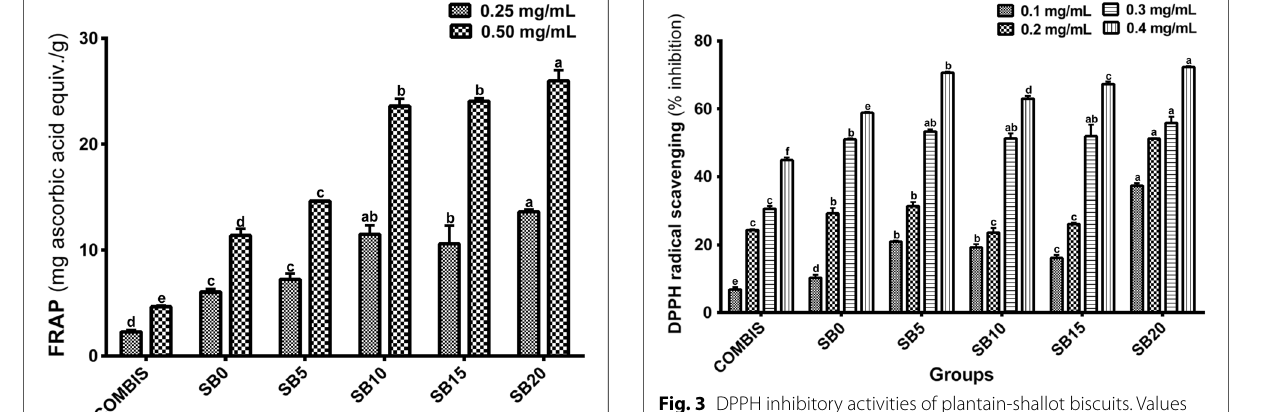
SD ( n 3). Bars with different letters are ± = 5% Shallot biscuit, +